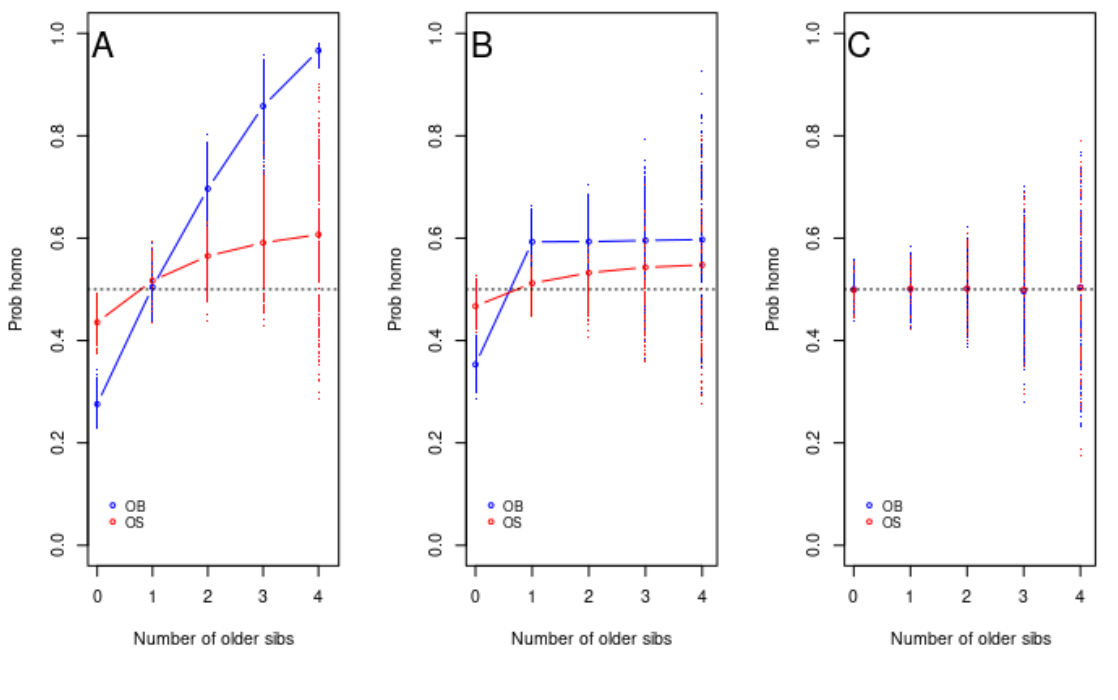
Figure 1 . Apparent SBOE when sampling men from a population with only an FBOE. A) FBOE generated with function f5 (cf Table S1). B) FBOE generated with function f7. C) Control (no FBOE). For each of the 1000 replicates, 500 heterosexual and 500 homosexual men were randomly sampled, and the proportion of homosexual men was computed for each older brother (blue) or older sister (red) category and is represented as a dot. The mean for these replicates, for each category of older siblings, is depicted as an empty circle with the corresponding colour. The dotted black line represents the expected curve when sexual orientation is independent of male birth rank.